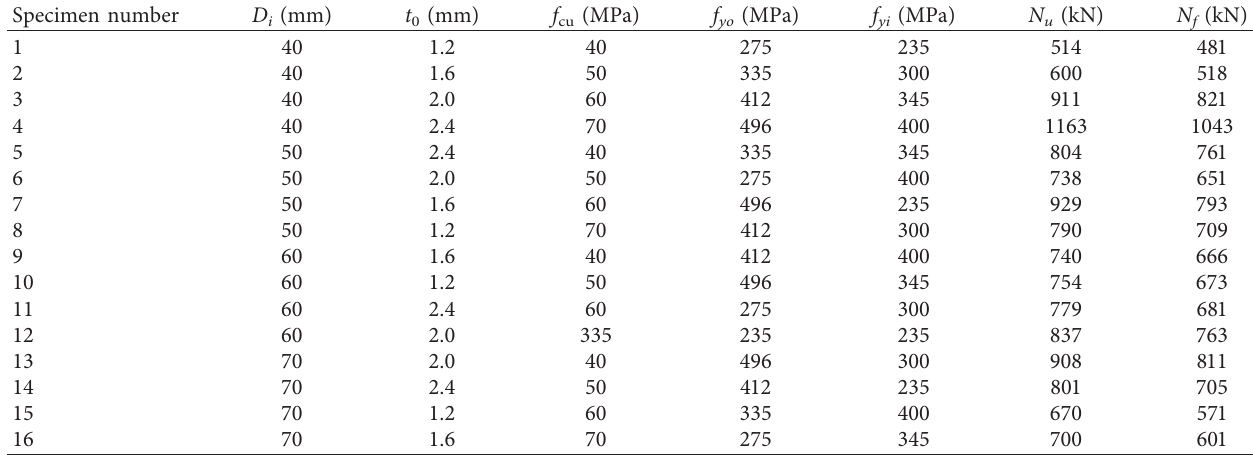
Table 4: Model parameter level settings.